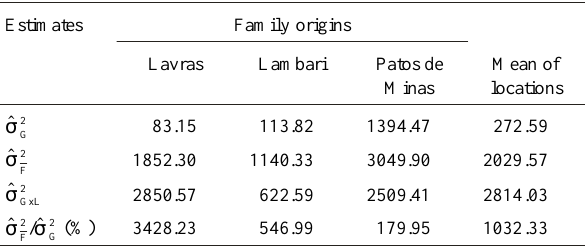
Table III - Es ti mates of ge netic vari ance ( $ s G2 ), phenotypic vari ance ( $ s F2 ) and fam ily x lo ca tion in ter ac tion vari ance ( $ s GxL2 ), ob tained from the joint anal y sis of vari ance for grain yield (g/plot) in the three lo ca tions in